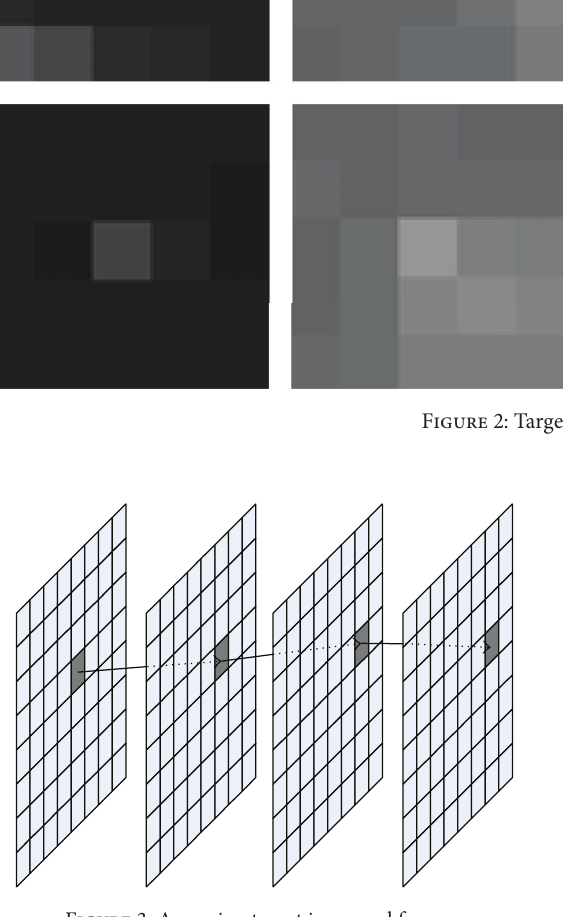
Figure 3: A moving target in several frames.